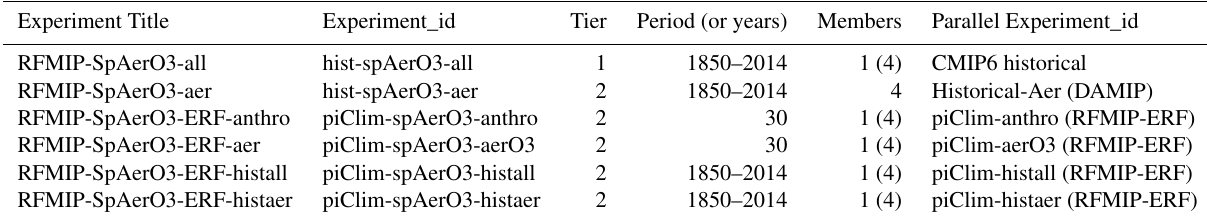
Table 5. RFMIP simulations with specified anthropogenic aerosols (SpAer). All simulations are all based on the MACv2-SP prescription of anthropogenic aerosol optical and cloud active properties. They are only to be performed to replicate other simulations in the DECK, within the ERF component of RFMIP, or within the Detection and Attribution Model Intercomparison Project (DAMIP) in the case when MACv2-SP is not used as the default aerosol climatology in the parent